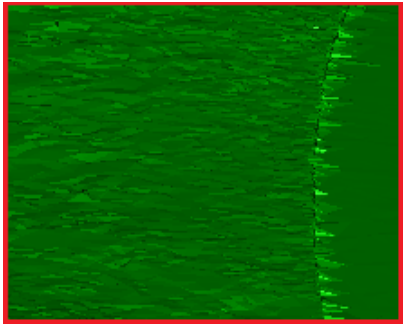
Figure 13. Result obtained after Step 2 application with PMax > 0.05 m and Trimax < 0.75